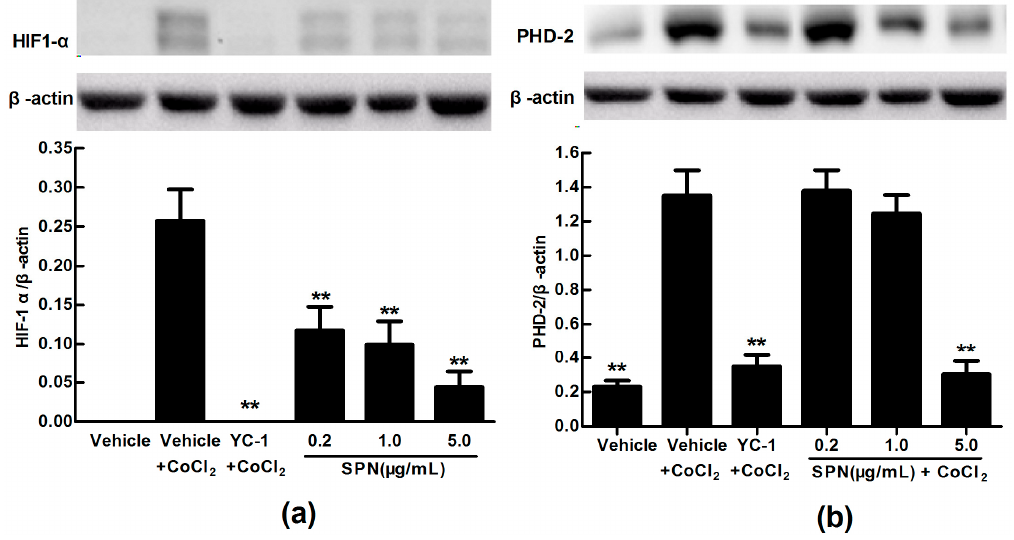
Figure 4. Effects of SPN on the protein expressions of HIF-1 α and PHD-2 in ARPE-19 cells at 24 h of normoxia or hypoxic conditions. ( a ): HIF-1 α protein expression; ( b ): PHD-2 protein expression. The results are representative of at least three independent experiments run in triplicate and expressed as the mean ± SD ( n = 9). ** p < 0.01 vs. vehicle plus CoCl 2 -treated group. The control cells were treated with vehicle (culture medium containing 0.1% DMSO). Beta-actin was used as the loading control.